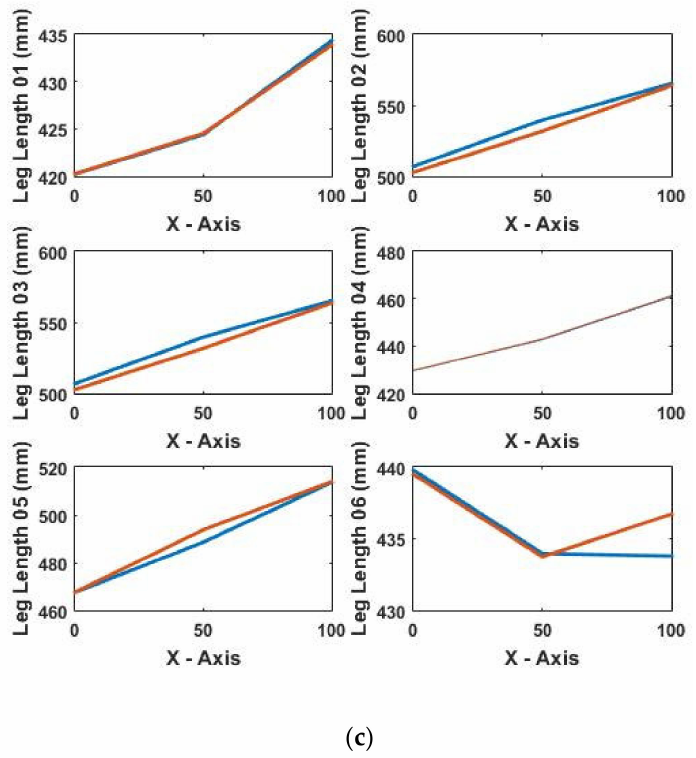
Figure 17. ( a ) Actual and desired leg lengths during test 01 for experimental validation; ( b ) Actual and desired leg lengths during test 02 for experimental validation; ( c ) Actual and desired leg lengths during test 03 for experimental validation.